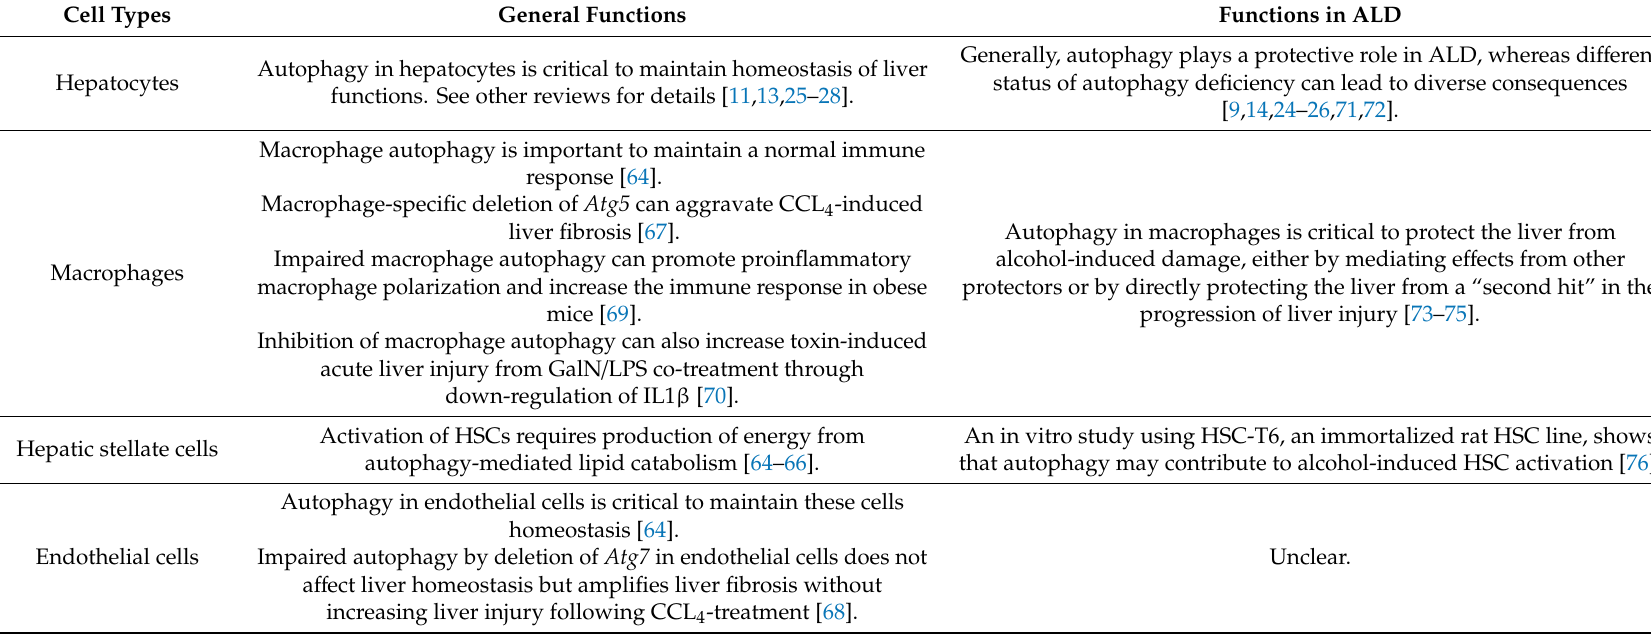
Table 1. Autophagy in di ff erent types of liver